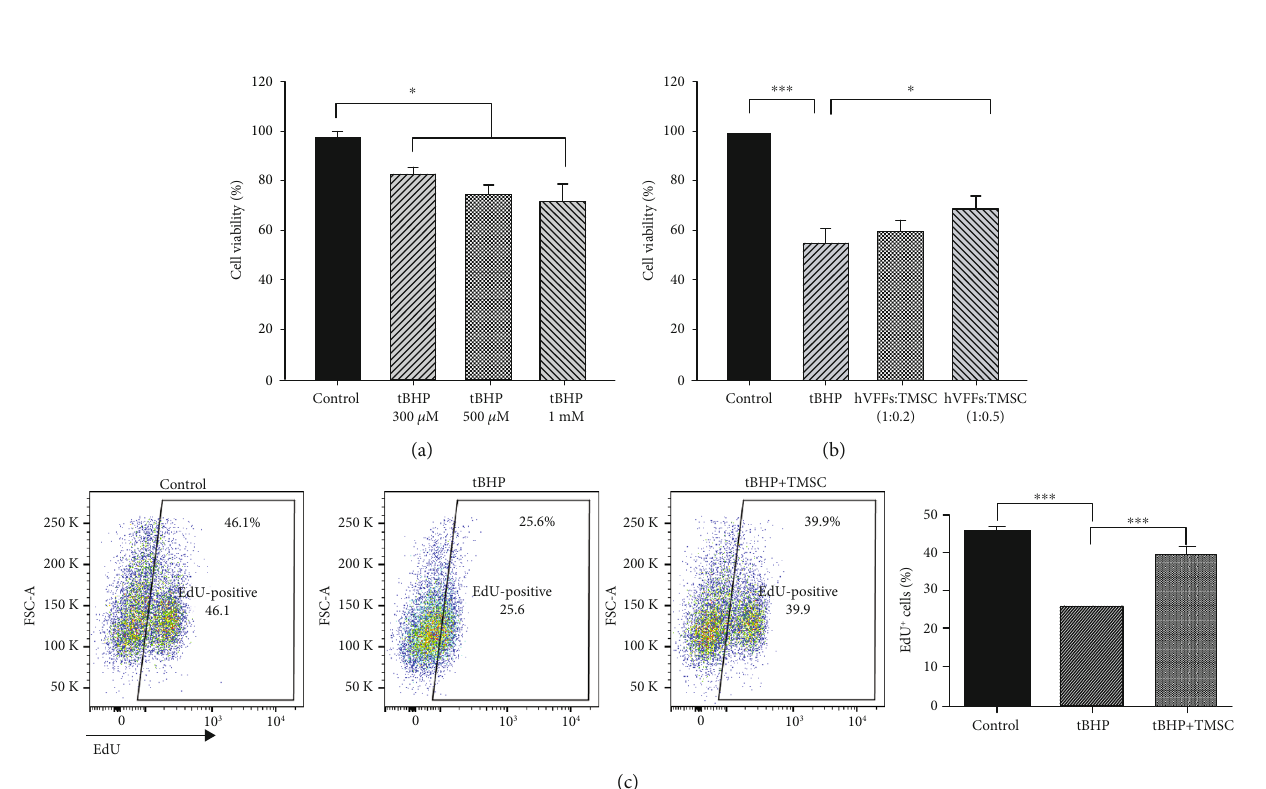
Figure 1: Viability and proliferation of human vocal fold fi broblasts (hVFFs) after tert -butyl hydroperoxide (tBHP) treatment and coculture with tonsil-derived mesenchymal stem cells (TMSCs). (a) Cell viability was signi fi cantly decreased following treatment with tBHP in a dose-dependent manner. (b) Of the di ff erent hVFF :TMSC ratios examined, 1:0.5 ratio exhibited signi fi cant recovery of cell viability. (c) Representative fl ow cytometry results and integrated proportion for EdU + proliferating cells. Results are 3 technical replicates of TMSC from one donor. Representative results from two di ff erent TMSCs with similar tendency were presented. For multigroup comparison, ANOVA followed by the Bonferroni post hoc test was used for statistics. Results are shown as the mean ± SD . ∗ P < 0 : 05 , ∗∗∗ P < 0 : 001